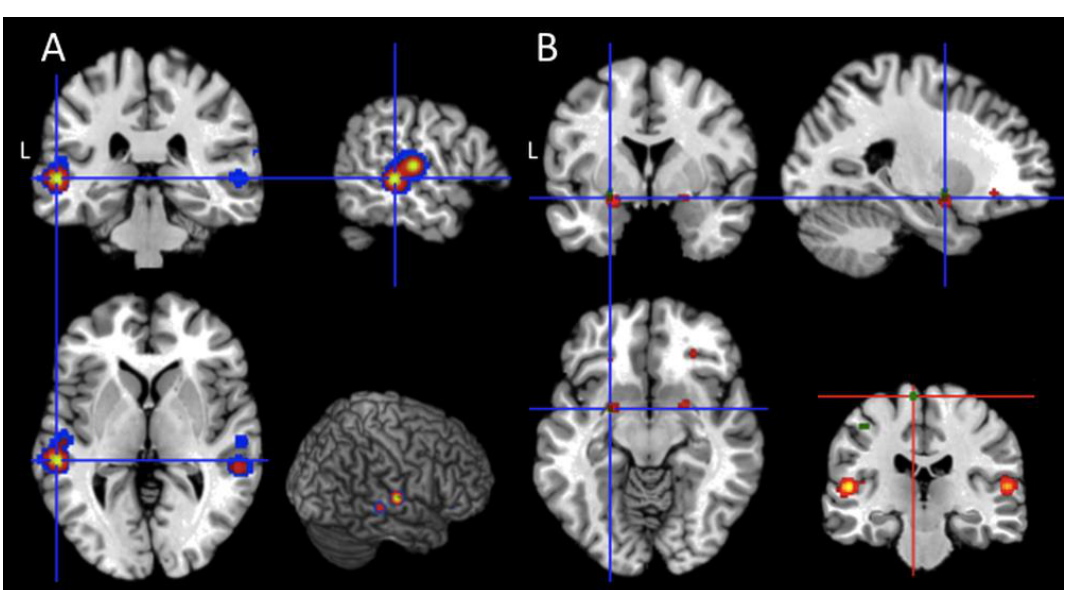
Figure 2. Intersection between patients and task category. The red regions represent the UWS and MCS map. ( A ) Overlap between UWS and MCS map (in red) and the passive maps (in blue; p < 0.001 uncorrected) at the level of the left superior and middle temporal gyri; the three-dimensional render shows the overlap at the level of the right lateral temporal cortices. ( B ) Anatomical overlap between the UWS and MCS map (in red) and the active map (in green; p < 0.001 uncorrected). The blue cross is centred over the left amygdala. Finally, the red cross depicted in the coronal section at the bottom of panel B is centred over the left paracentral lobule, which is specifically associated with “active tasks”.